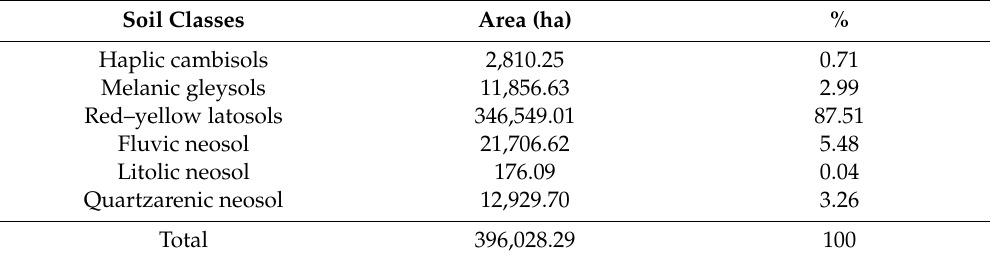
Figure 4. Soil map of the Pandeiros River basin. Table 4. Spatial distribution and proportion of soil classes in the Pandeiros River basin.